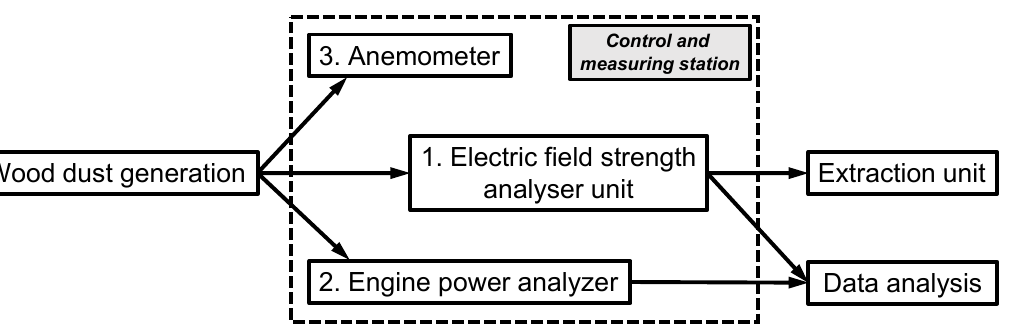
Figure 3. Milling machine with circular saw blade for the wood dust generation.